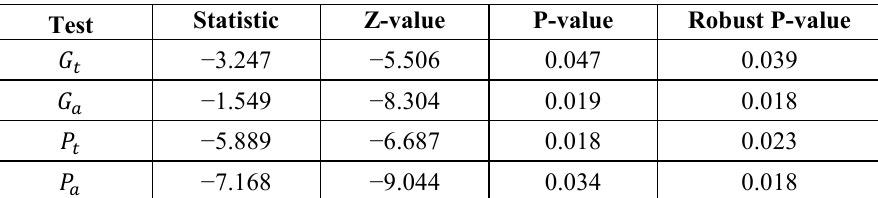
Table 3. Westerlund’s Cointegration Test